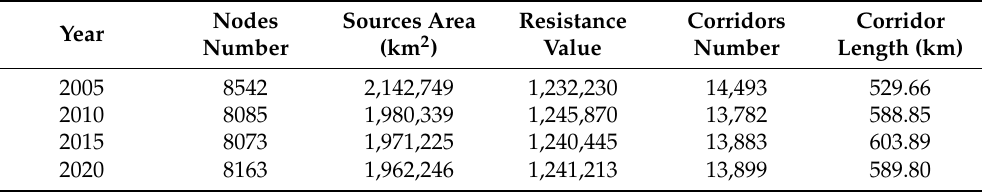
Table 3. Temporal and spatial evolution of ecological spatial network structure.